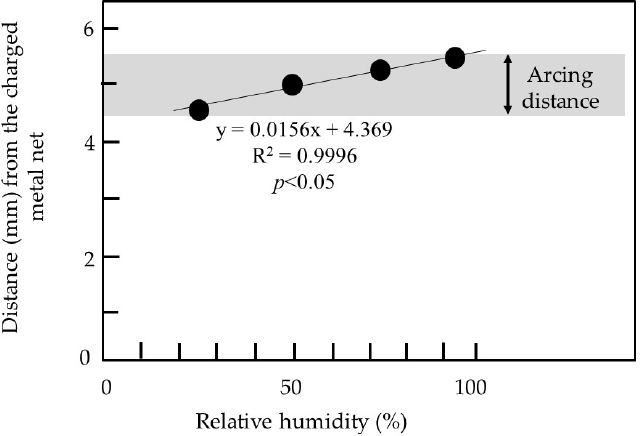
Figure 4. The distance from the pole required to cause arcing under different relative humidity (RH) conditions. Two identical expanded metal nets (negatively charged and grounded metal nets) were horizontally arranged, and the arcing distance (distance from the charged net) was determined by changing the distance between them at each RH.